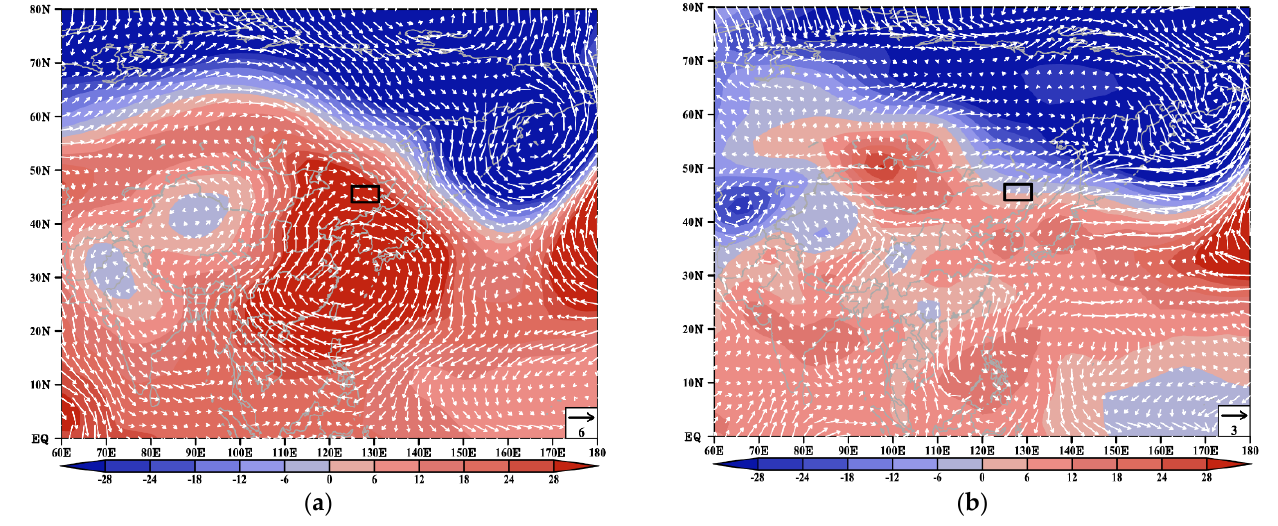
Figure 2. The anomalies in geopotential height (unit: 10 gpm, shaded) and wind (unit: m s −1 , vector) for January–February 2019 at ( a ) 500 hPa and ( b ) 1000 hPa, relative to the climatic mean for 1981–2010. The domain (125–131 ◦ E, 44–47 ◦ N) around Harbin is marked by black rectangle. The strong positive anomalous center of geopotential height at 500 hPa caused the warm air from the south to easily reach NEC. By comparison, at the lower level (at 1000 hPa), Harbin is essentially in the area of negative height anomalies. This vertical distribution caused the geopotential thickness of the middle troposphere (e.g., 600, 700 and 850 hPa) over Harbin to thicken, which indicates that the air at these levels was warmer than normal.